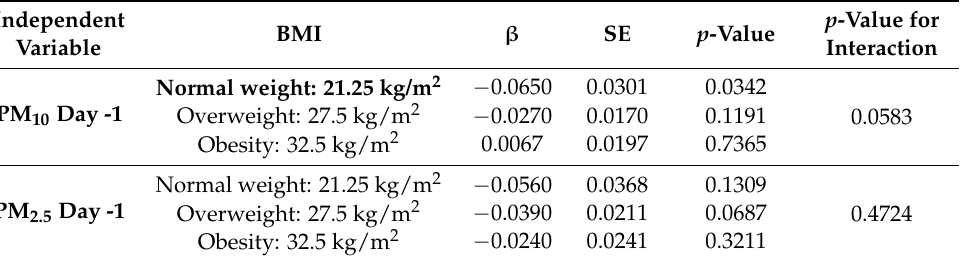
Table 4. Modifying effect of BMI on the association between HDL-mediated reduction in macrophage cholesterol mass and PM exposure the day before the